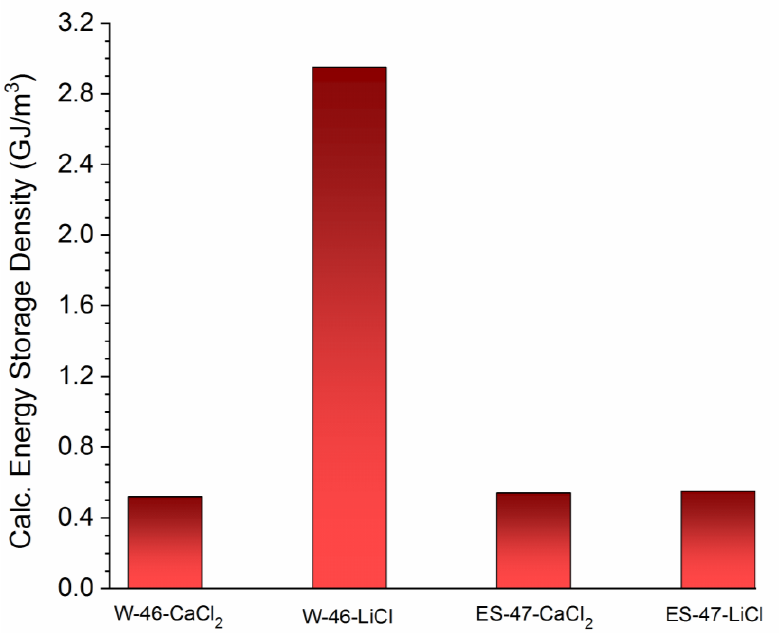
Figure 7. The integral heat of sorption of the composites for space heating storage cycle: sorption temperature of 35 °C, evaporation temperature of 5 °C, desorption temperature of 90 °C, and condensation temperature of 30 °C.